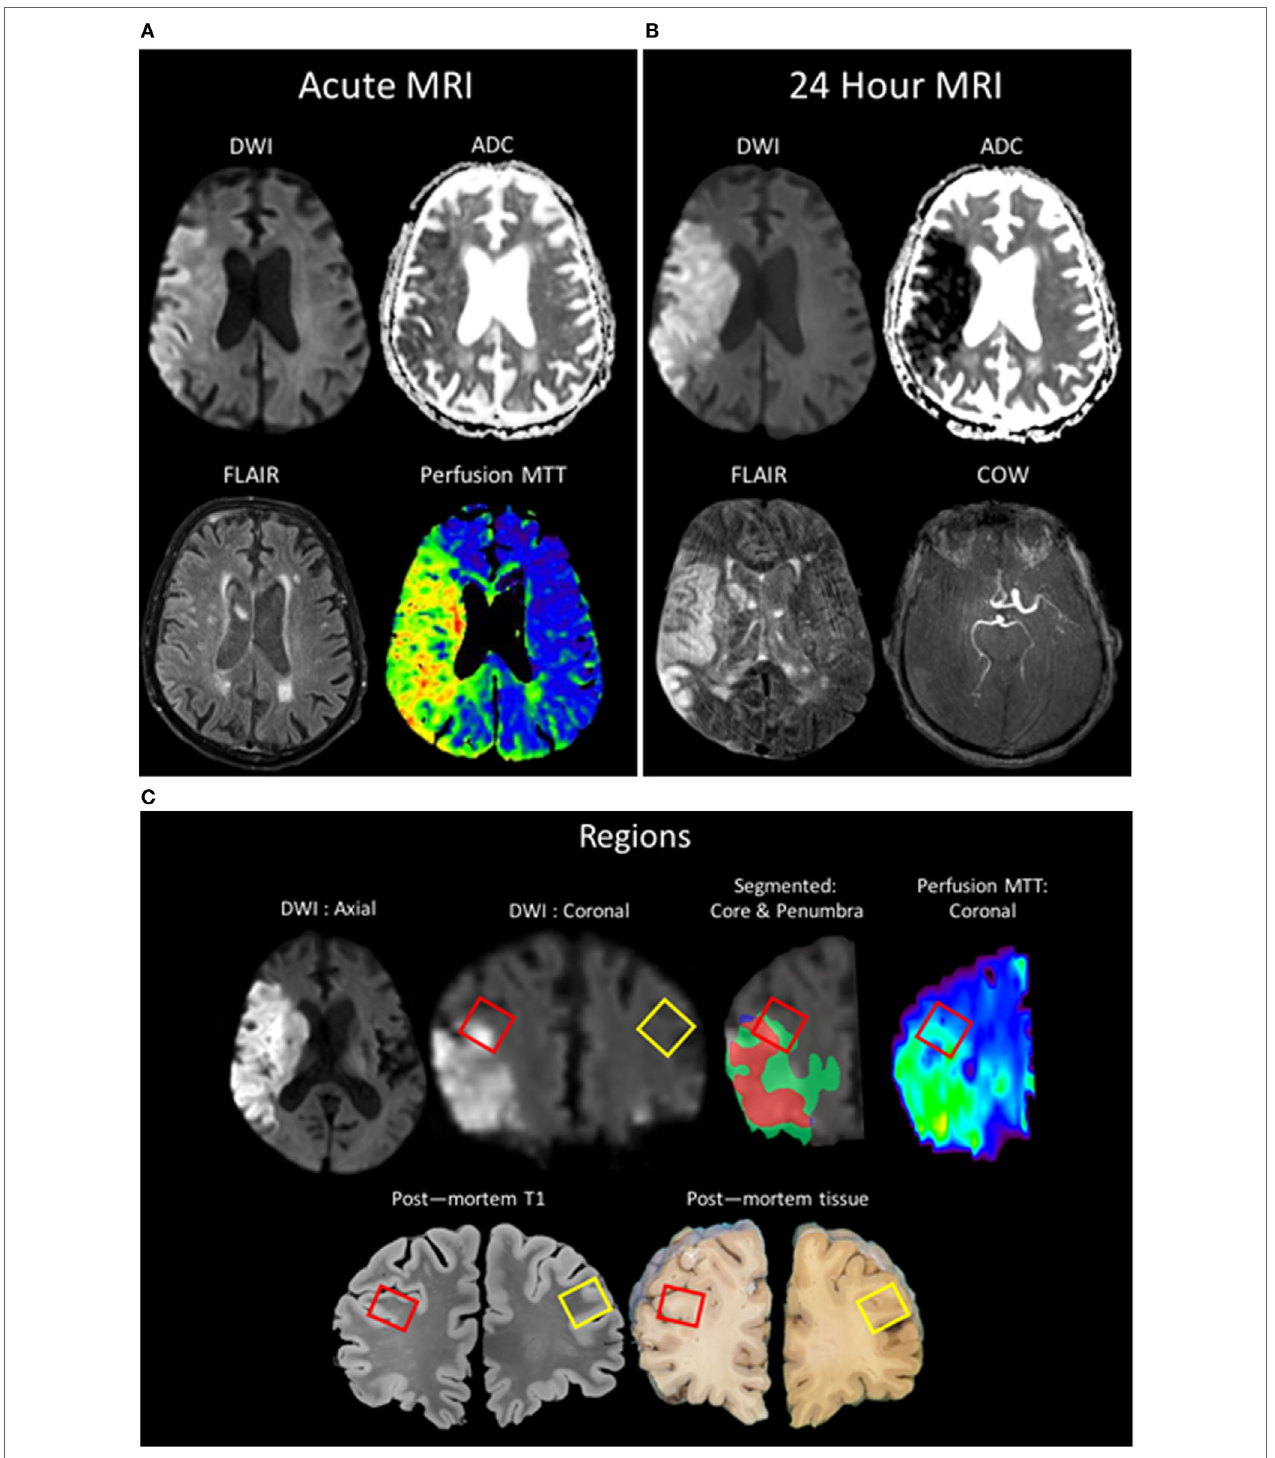
FIGURe 1 | Patient MR images taken during clinical evaluation (acute) (a) and 24 h later (B) [pictured: trace-weighted diffusion weighted imaging (DWI) and ADC maps, fluid-attenuated inversion recovery (FLAIR), perfusion mean-transit time (MTT), and a minimum intensity projection of the circle of willis]. (C) MR images taken postmortem were analyzed to co-localize regions of interest identified in vivo with the postmortem sample (red boxes: ipsilateral ROI; yellow boxes: contralateral). Two regions of interest were segmented, the region of the core (red) taken from the baseline DWI and the region of the penumbra as the mismatch between the MTT and the DWI (green), and overlaid onto the 24-h